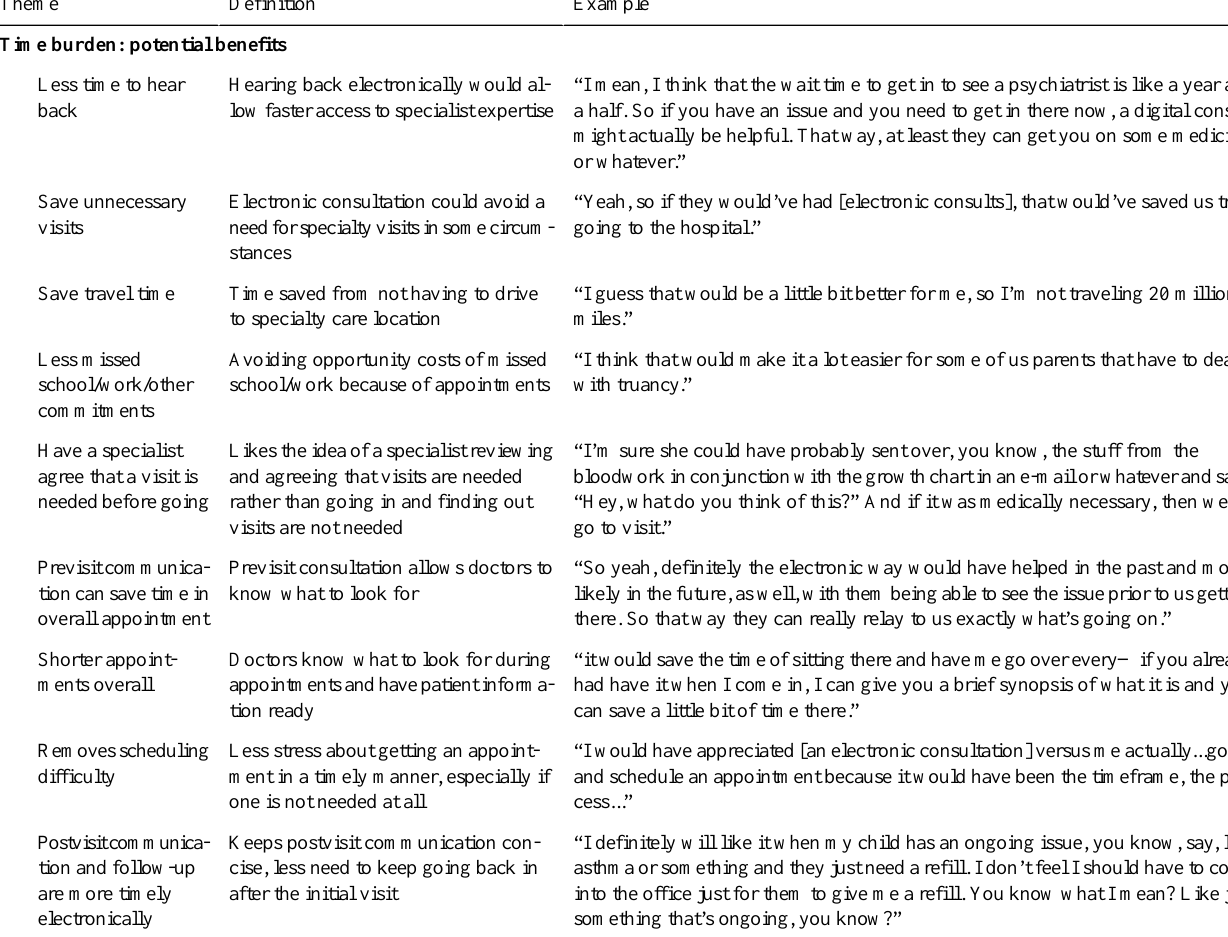
Table 2. Parent perspectives on anticipated benefits and risks of electronic